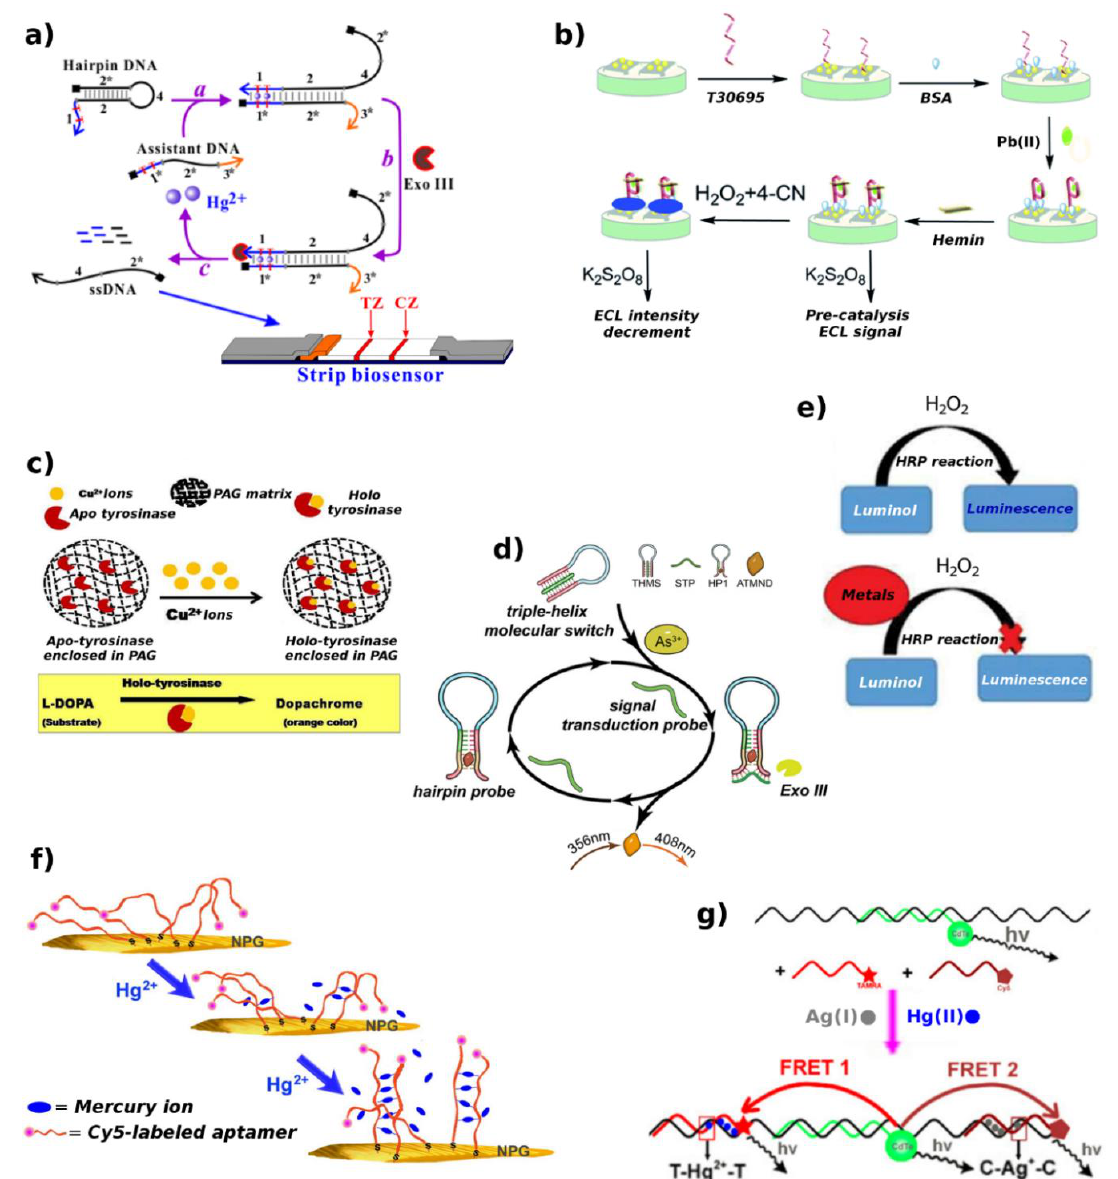
Figure 11. Most sensitive biorecognition strategy / specific HM ion, in real samples. ( a ) Disposable strip biosensor based on Hg 2 + -induced toehold binding and Exo III-assisted signal amplification [99]; ( b ) ECL Pb 2 + sensor based on hemin / G4-based DNAzyme biocatalysis [85]; ( c ) Cu 2 + triggered conversion of apo-tyrosinase disc into holo-tyrosinase one, and consequent L-DOPA to dopachrome transformation [93]; ( d ) As 3 + detection by Exo III-assisted cascade target-recycling amplification scheme [75]; ( e ) Possible on-site analysis of HMs by means of the HRP-based bioassay [40]; ( f ) Aptamer-modified NPG-based SERRS sensing of Hg 2 + [114]; ( g ) Ag + and Hg 2 + detection by FRET between QD and organic dyes [122]. Adapted with permission of the Publishers.